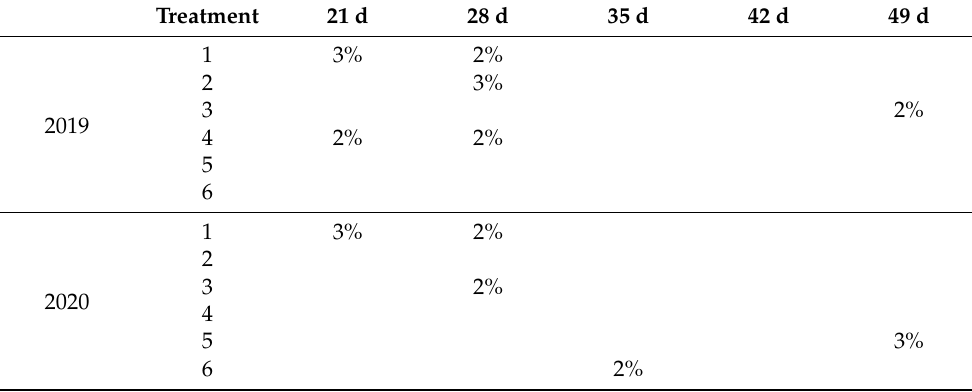
Table 6. Percentage of rotten sweet cherries cv. Satin for each year, treatment and storage time. Before 21 days of conservation, no rotten fruits were found. Treatment 1 was located at FO under normal atmosphere conditions. Treatments 2 to 6 were located at RC. Treatment 2 was under normal atmosphere conditions. The atmosphere composition of treatments 3 to 6 was, respectively, 3%O 2 – until the 28th day. Treatments 3 to 6 were evaluated until the 49th day. The absence of values indicates 0% rotten sweet